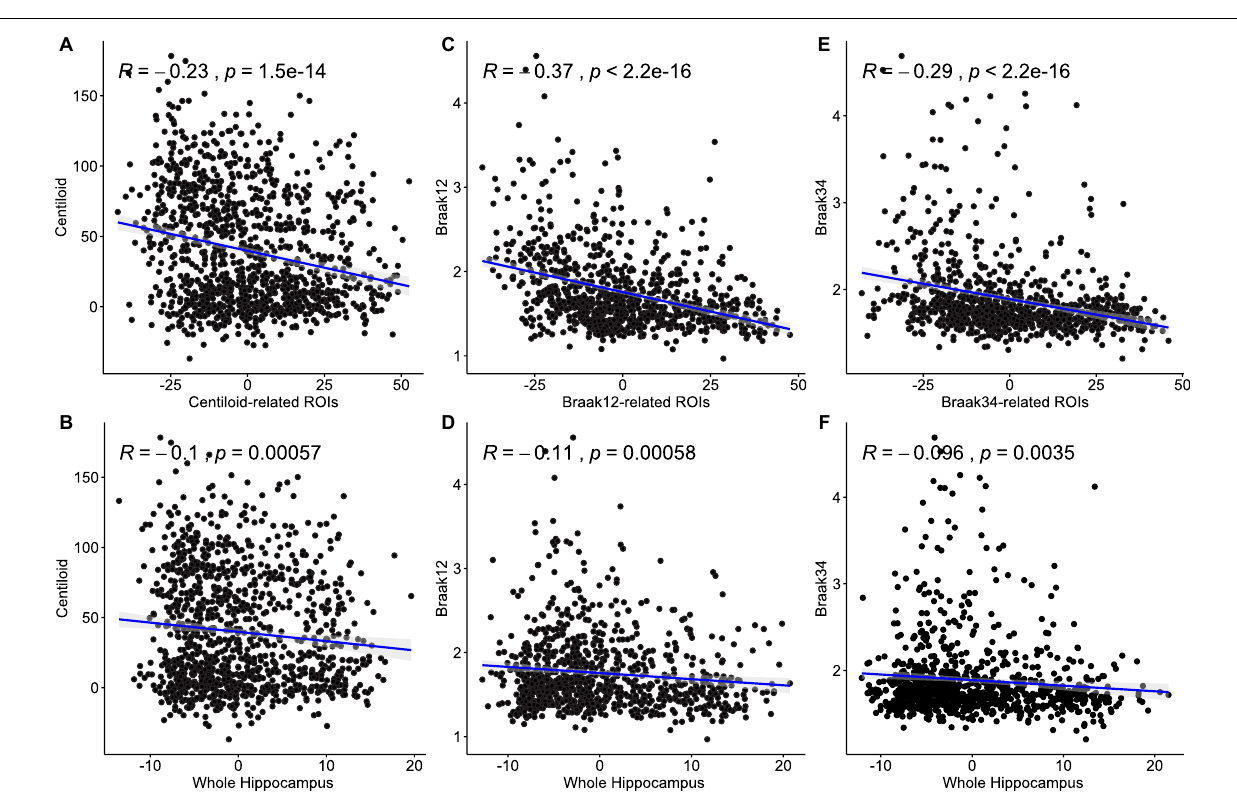
FIGURE 6 | Pearson correlation between morphometry features and measures for A β and tau deposition. The top three subfigures (A,C,E) illustrate the correlation between the values on our selected ROIs and the measure for A β or tau deposition. The bottom three (B,D,F) are between the value on the whole hippocampal surface and the measure for A β or tau deposition. The correlation coefficients and p-values are shown in each